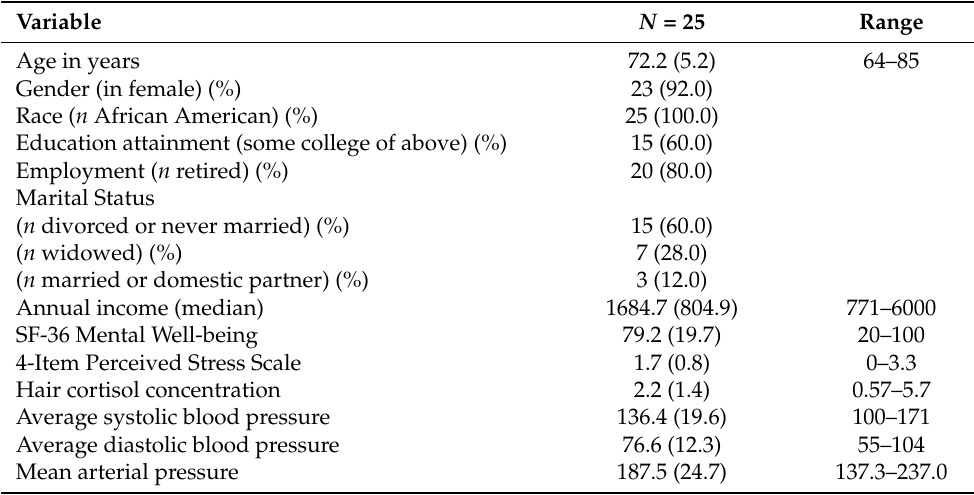
Table 1. Characteristics of the participants 1